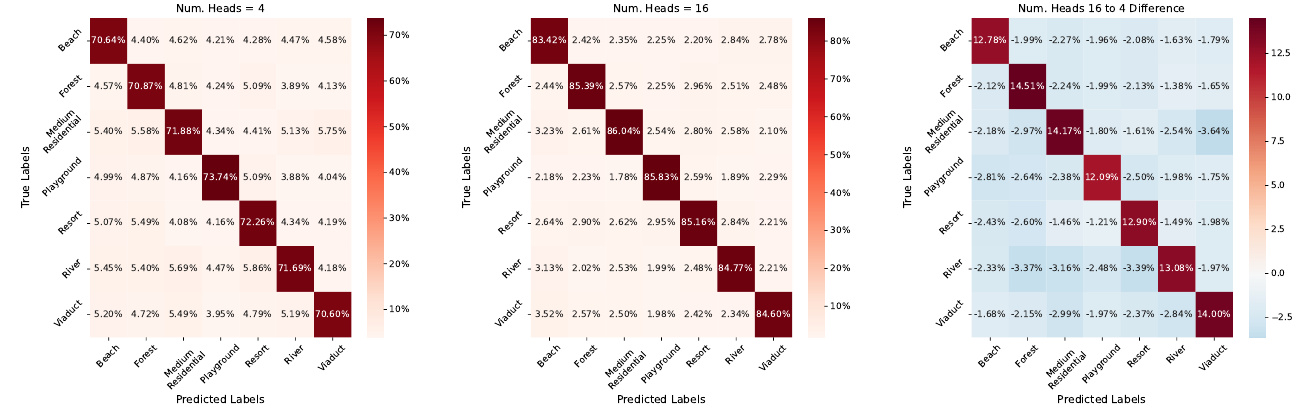
Figure 13. Confusion matrices and their difference on dataset AID with graph transformer attention heads equaling 4 and 16.